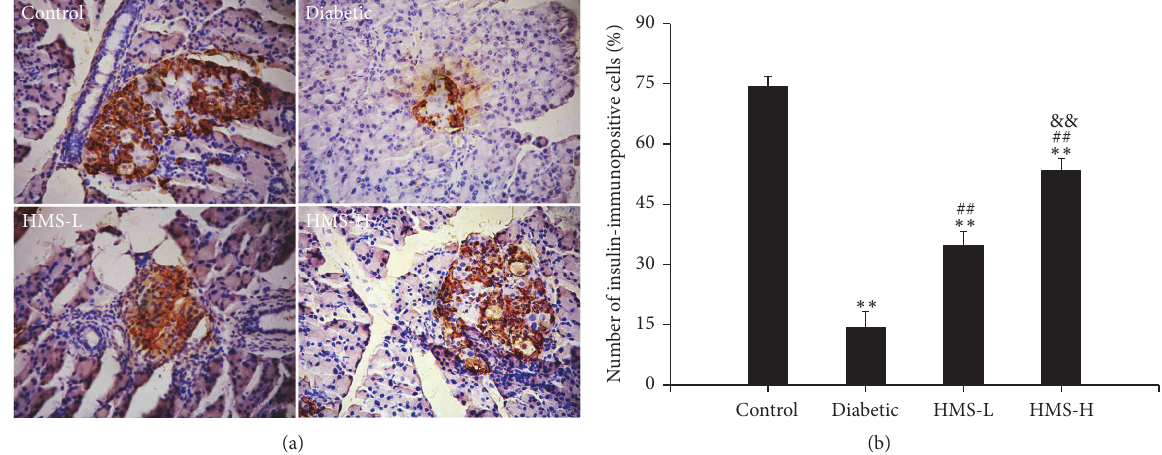
Figure 5: Effects of HMS5552 on insulin immunoreactivity in the rat pancreas. Pancreas tissue sections stained with anti-insulin antibody are shown at 200x magnification (a), and the number of insulin-immunopositive cells in islets was analyzed (b). HMS-L group, low-dose (10mg/kg) HMS5552-treated diabetic group; HMS-H group, high-dose (30mg/kg) HMS5552-treated diabetic group. The data are expressed as the mean ± SD ( 𝑛 = 6 ). ∗∗ 𝑃 < 0.01 , compared with the control group; ## 𝑃 < 0.01 , compared with the diabetic group; && 𝑃 < 0.01 , compared with the HMS-L